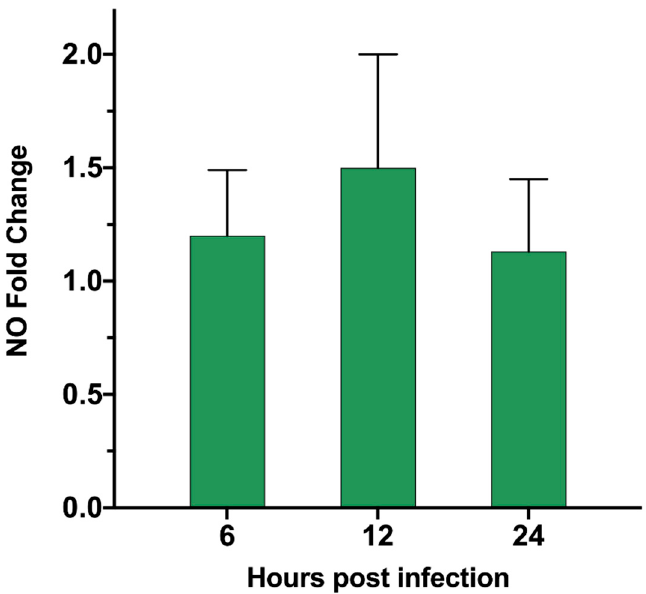
Figure 7. Nitric oxide intracellular level in PAM cells infected by ASFV. PAM cells were infected by ASFV. At 6, 12, and 24 h post-infection, the cell supernatant was harvested, and the change in the amount of NO in the supernatant relative to the mock-infected group was detected.